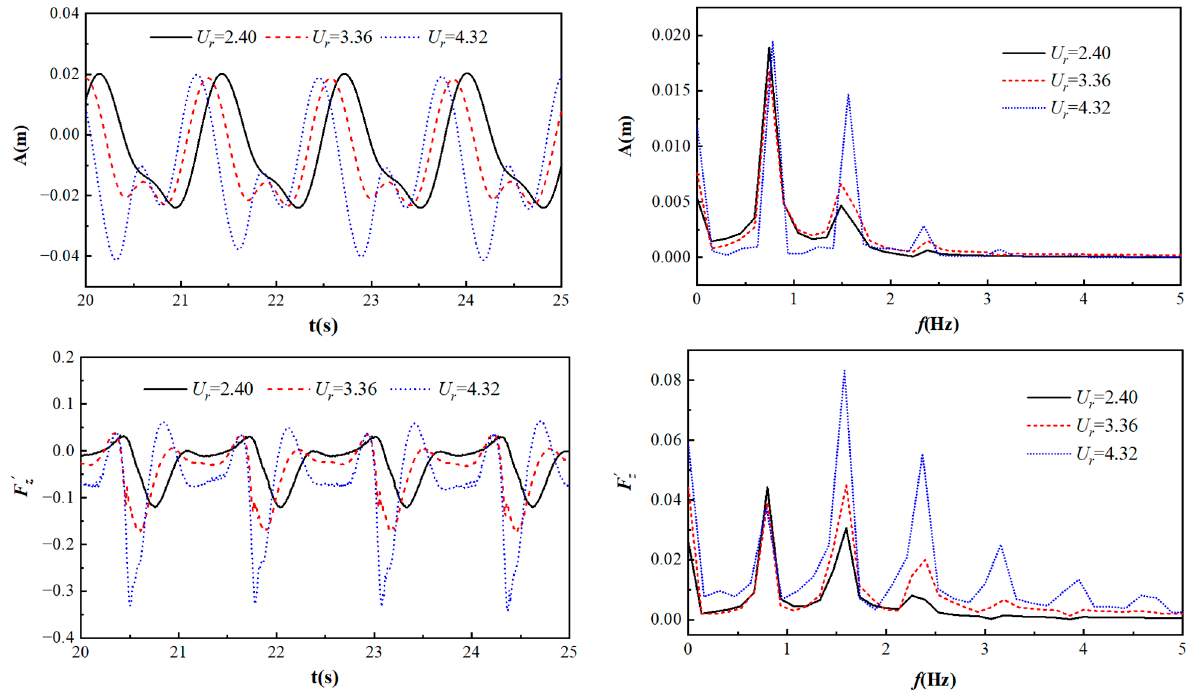
Figure 17. Time series and spectrum of wave–current force under different U r.